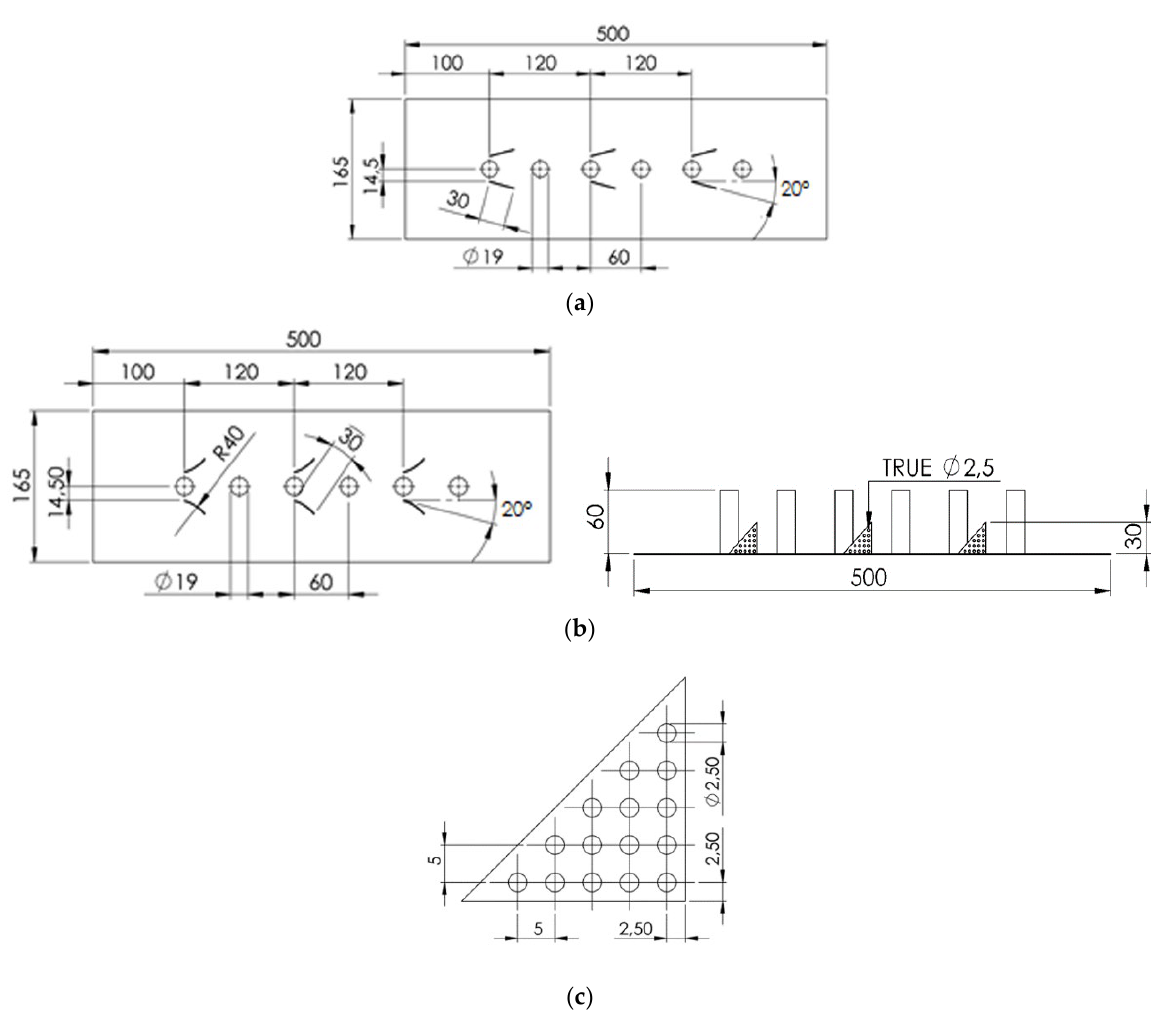
Figure 2. Geometry of the test specimen: ( a ) top view of three pairs of in-line PDW and PCDW VGs; ( b ) side view of three pairs of in-line PDW and PCDW VGs; ( c ) geometry of the perforated